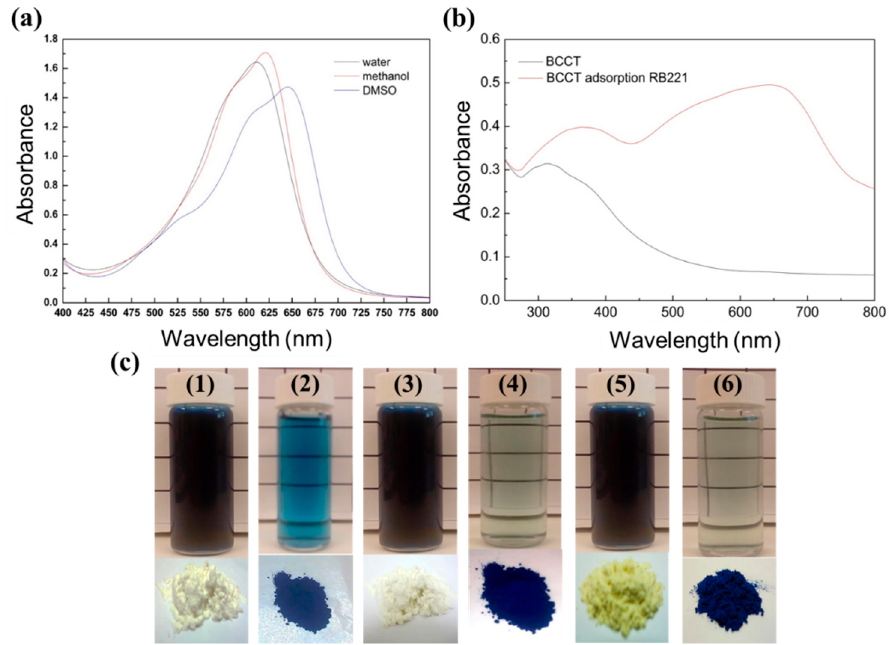
Figure 8. UV–Vis absorption spectroscopy: ( a ) changes in the UV–Vis spectra for the RB221 dye solutions prepared with different solvents (water, methanol, and DMSO) of concentration = 1.14 × 10 − 3 mol/L; and ( b ) UV–Vis spectra of BCCT before and after the dye adsorption. ( c ) Various adsorbents before and after the RB221 dye adsorption in solution: ( 1 and 2 ) α -chitosan and RB221-adsorbed α -chitosan; ( 3 and 4 ) β -chitosan and RB221-adsorbed β -chitosan; and ( 5 and 6 ) BCCT and RB221-adsorbed BCCT.